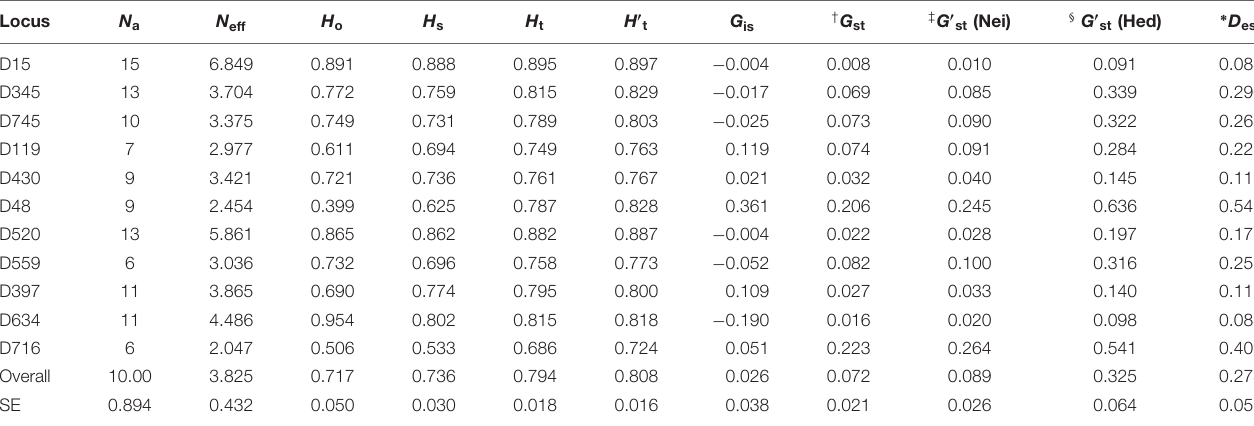
TABLE 1 | Summary statistics per locus for 11 de novo microsatellite markers for Dendrogyra cylindrus .